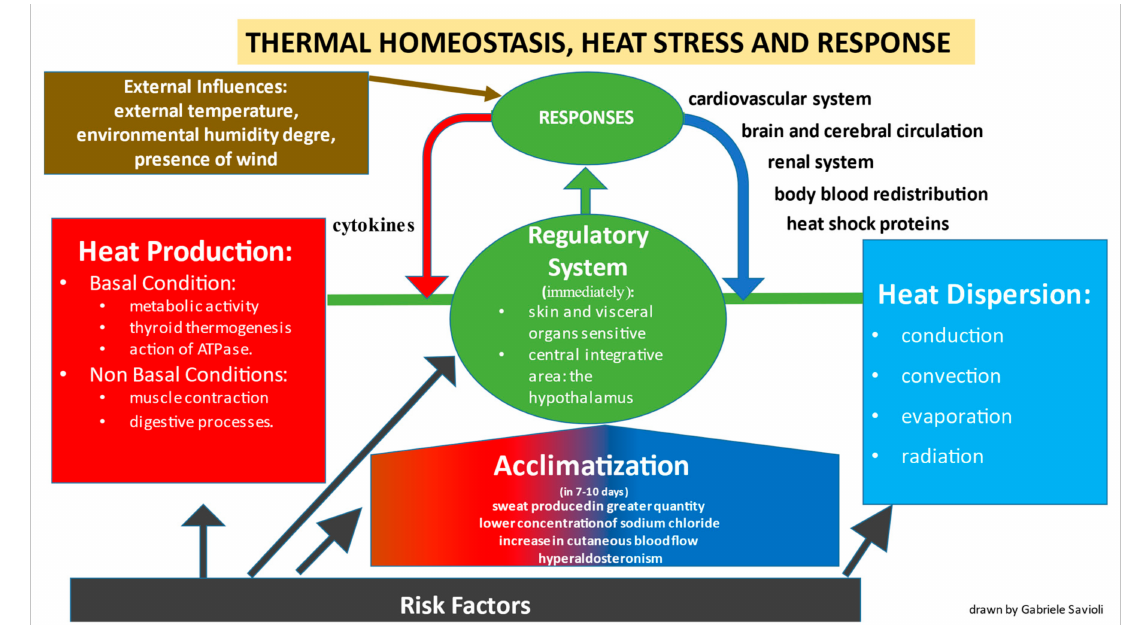
Figure 1. When the body is under heat stress, thermal homeostasis is maintained through the regu- lated balance (immediately for the regulatory system and after 7–10 days through the acclimatization process) among the factors that produce heat (red square) and heat dissipation (blue square). However, modifiable and non-modifiable risk factors can compromise both the regulation and acclimatization systems and the factors capable of producing or dispersing